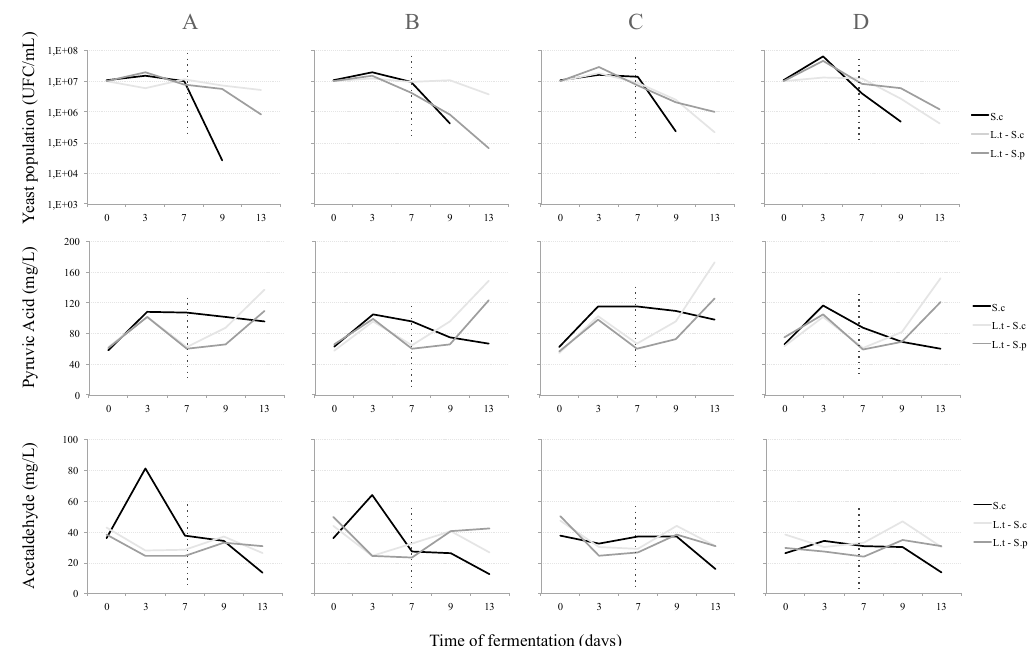
Figure 1. Yeast population growth. Data from acetaldehyde and pyruvic acid concentrations during fermentation. Analyses performed with gas chromatography (GC-FID) (acetaldehyde), enzymatic analyser (pyruvic acid) and plate counting (cells growth). Each point represents mean values ( n = 3). Dotted lines indicate the sequential yeast inoculation. ( A ) CAT, ( B ) PB2, ( C ) PC1 and ( D ) PA2.